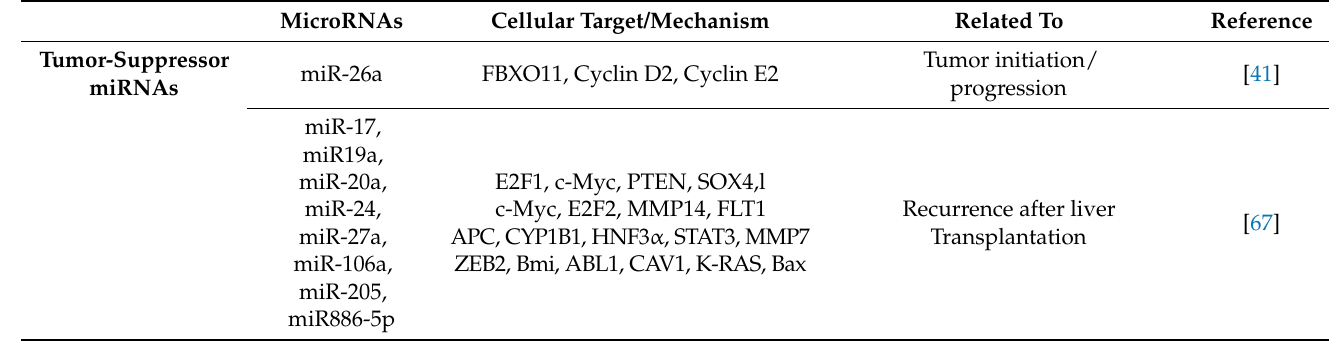
Table 1. Differentially expressed miRs in